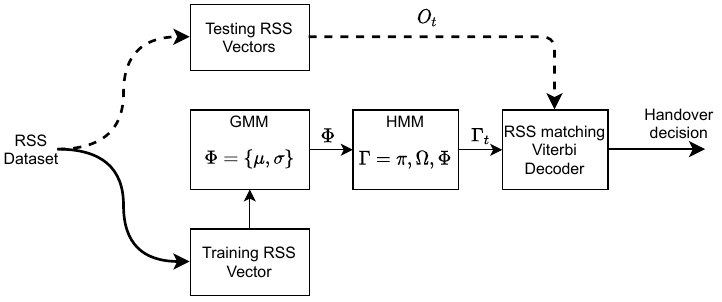
Figure 2. Enhanced VHO prediction system based on HMM.